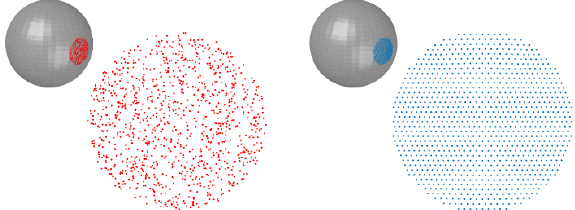
Figure 5. Comparison of points on a matching region that are collected from 40,962 random sample points from the uniform distribution (red, left ) described in 0 and from 40,962 vertices in the sixth-generation icosahedron-based vertices (blue, right ). The dots in the region on the sphere and the front views are shown. There are 1086 red dots and 1015 blue dots.